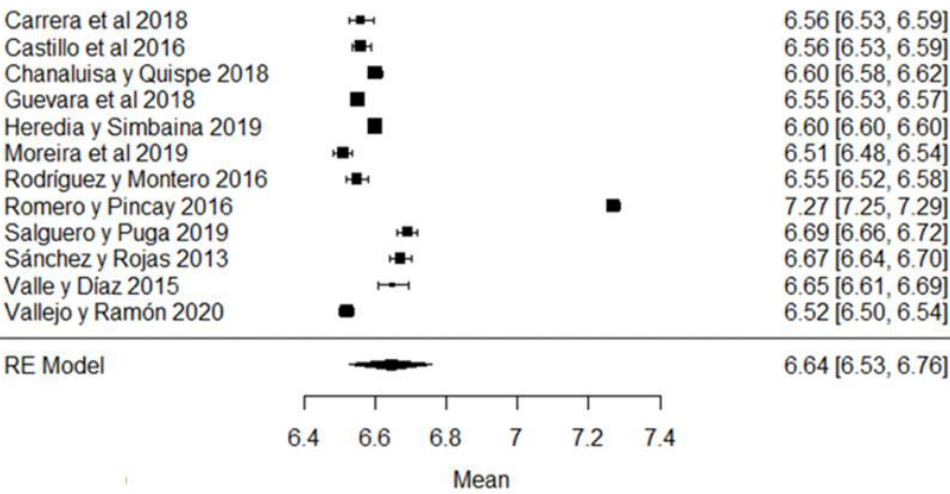
Figure 8. Forest plot of pH [16,18,21,23 – 26,39,43,44,51,57].